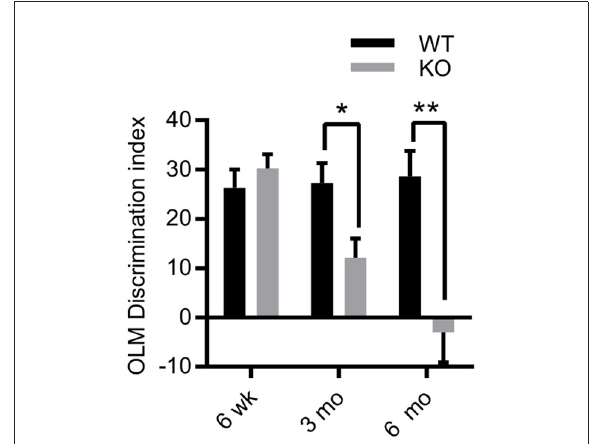
FIGURE1 Age-dependent deficits in hippocampal-dependent memory in ZnT3KO mice. Object location memory (OLM) task discrimination index shows age-dependent memory impairment in ZnT3KO mice, becoming significant at 3 months of age and profound by 6 months. WT, wild type, n = 8–13; KO, ZnT3KO, n = 14–16; DI, discrimination index [(novel-familiar)/(novel + familiar)*100]; * p < 0.05, ** p < 0.01. Data were analyzed by two-tailed unpaired t -test. Error bars indicate the mean ±